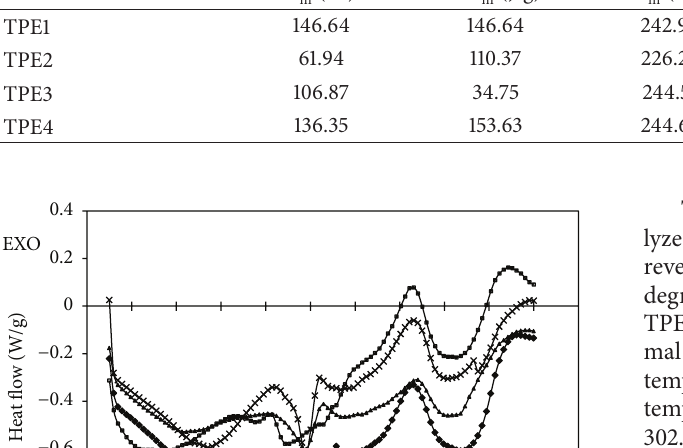
Table 3: Properties of melting process undergo at 100–200 ∘ C, 200–300 ∘ C, and 400–500 ∘ C. Samples/peaks’ region